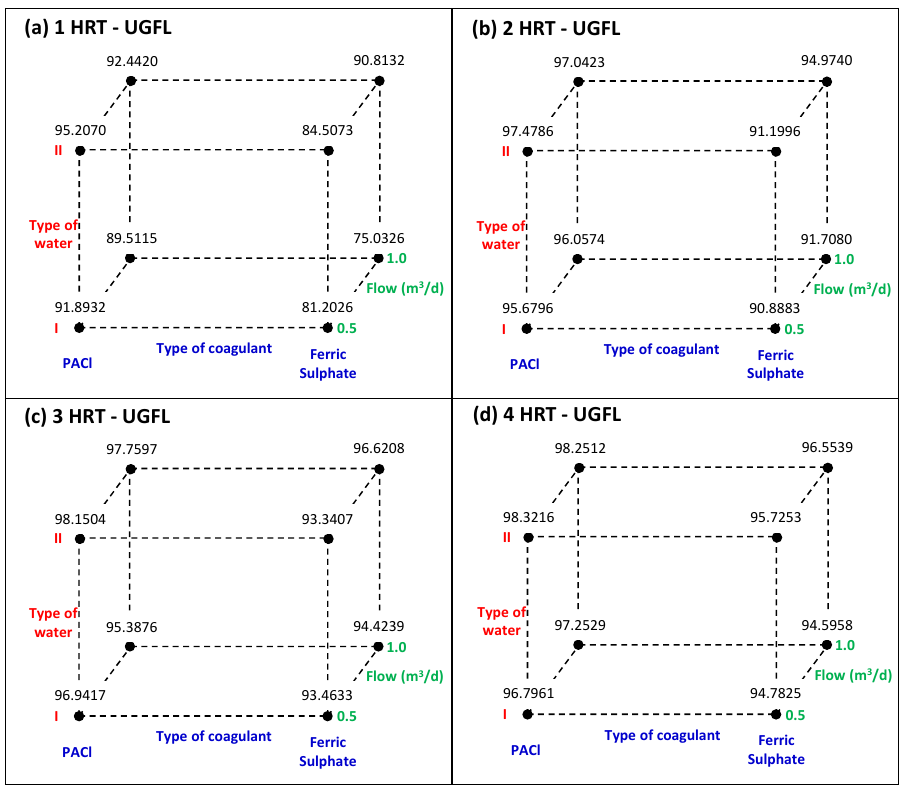
Figure 8. Cube plot (adjusted means) for turbidity removal (%) in